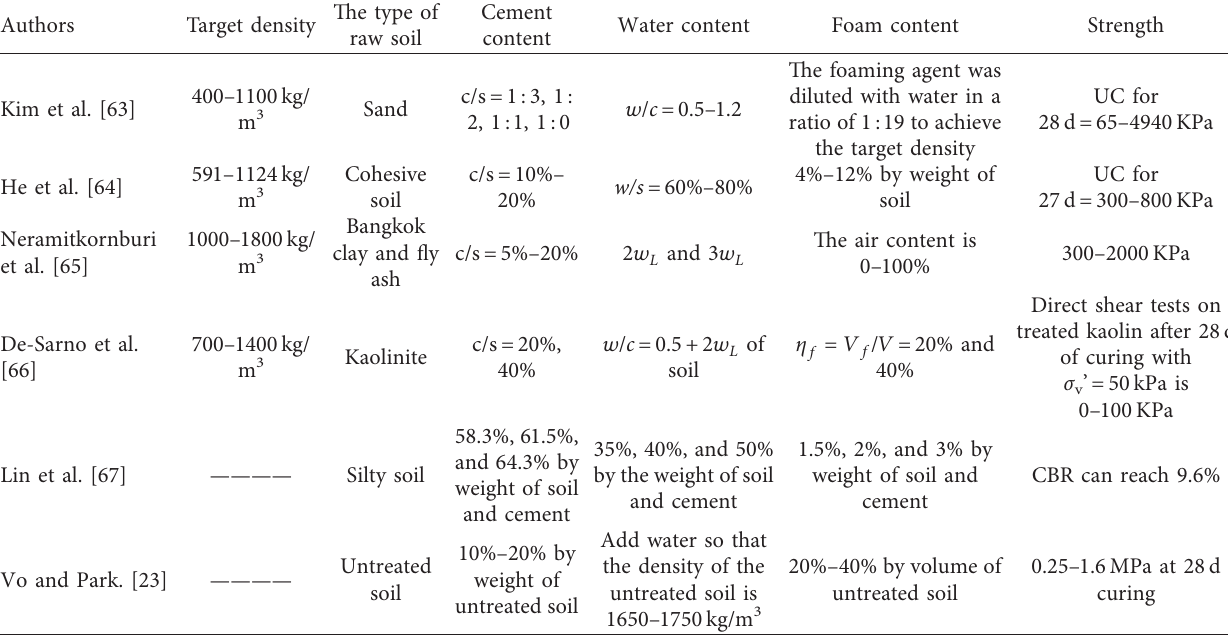
Table 2: Summary of the mixed proportions obtained by